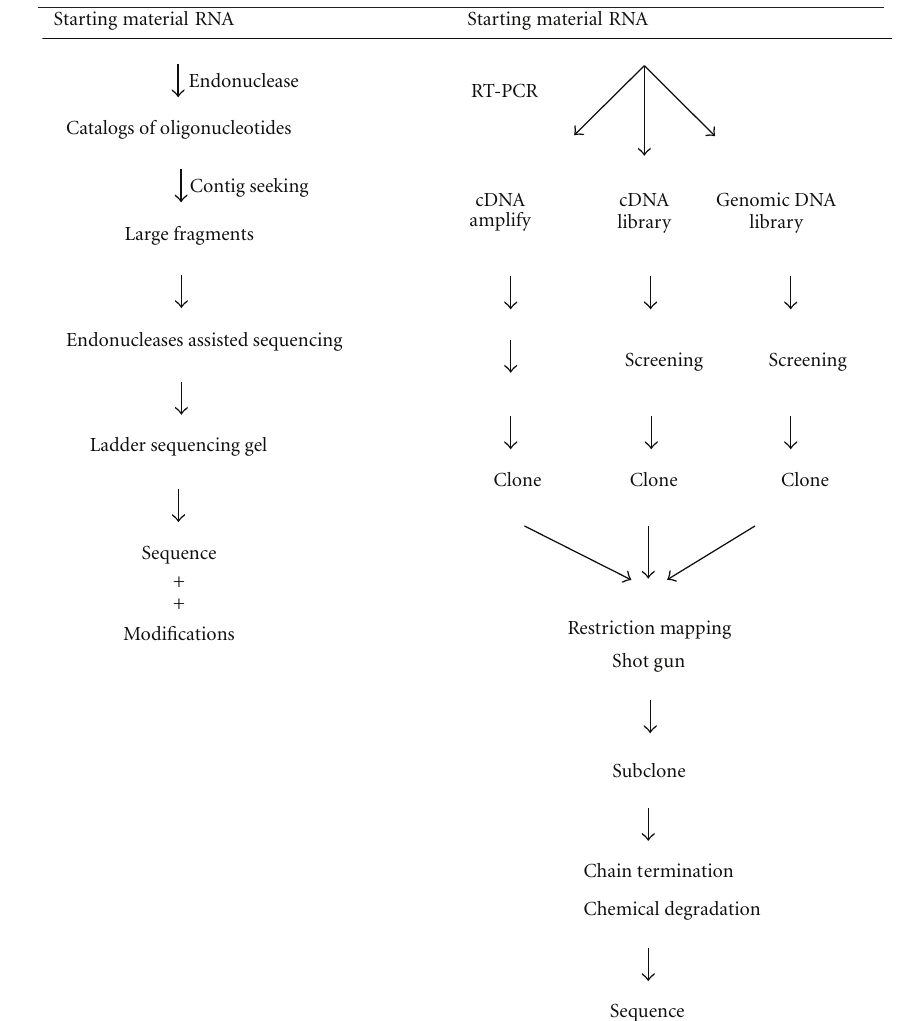
Table 6: General schemes of RNA sequencing. The direct and indirect methods of RNA sequencings are briefly outlined. The cDNA and DNA pathways are considered indirect